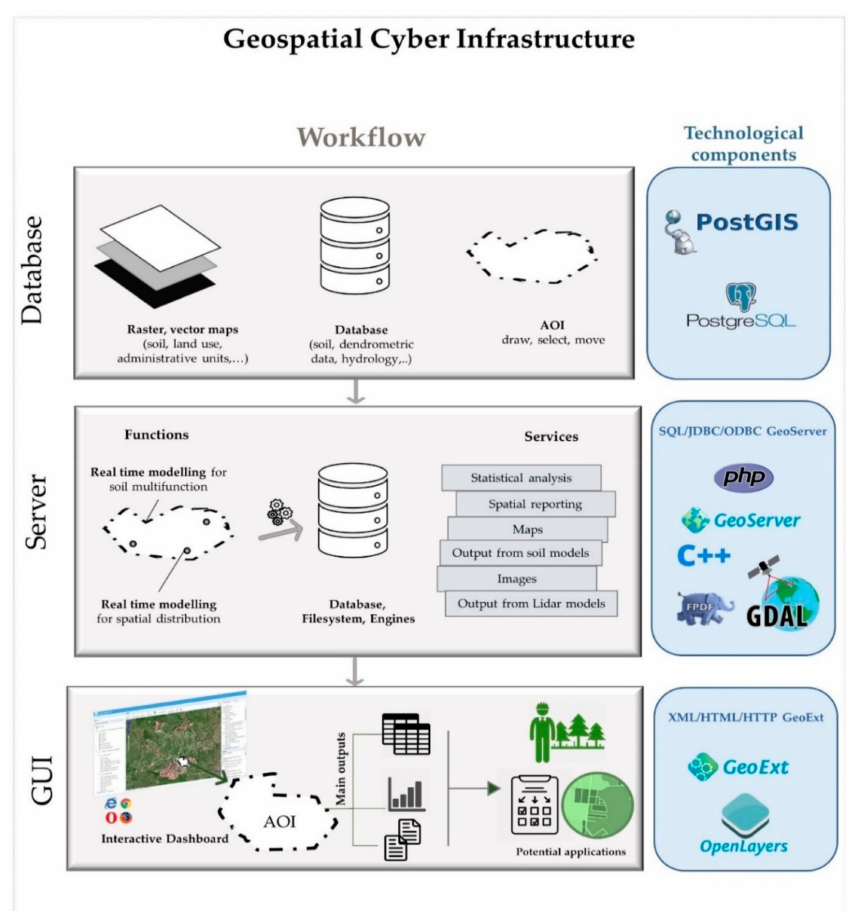
Figure 2. This is a synthetic diagram showing the basic structure of the SOILCONSWEB Geospatial CyberInfrastructure architecture in is functions and technological components. GUI is an abbreviation for Graphical User